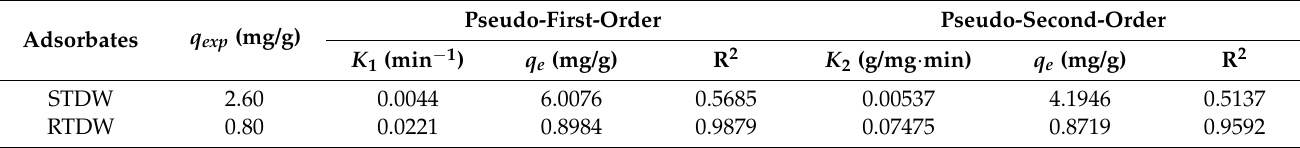
Table 5. Pseudo-first-order and pseudo-second-order data for the adsorption of STDW and RTDW. (Experimental conditions: C o STDW = 100 mg/L; C o RTDW = 10.0 mg/L; absorbent dosage = 1.0